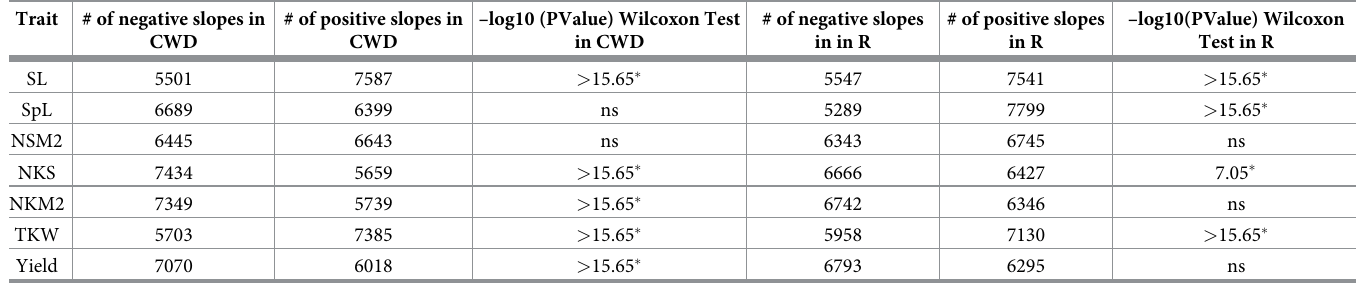
Table 3. Number of SNPs with a negative and positive effect on traits under CWD and R conditions. Trait # of negative slopes in